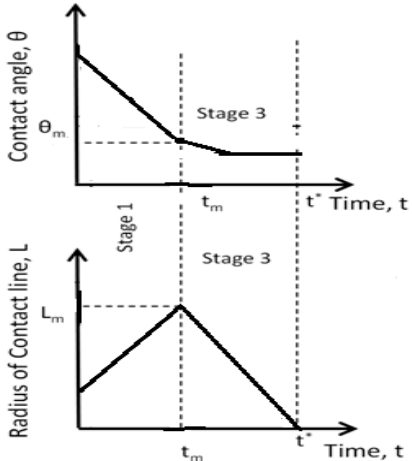
Figure 1. Schematics of three stages of spreading/imbibition of droplet over porous substrate in the case of partial wetting: L ad is the maximum radius of droplet base, θ ad is the static advancing contact angle, t ad is the time when θ ad is reached, θ r is the static receding contact angle , t r is the time when θ r is reached and t* is the time when spreading/imbibition is finished completely. [35].